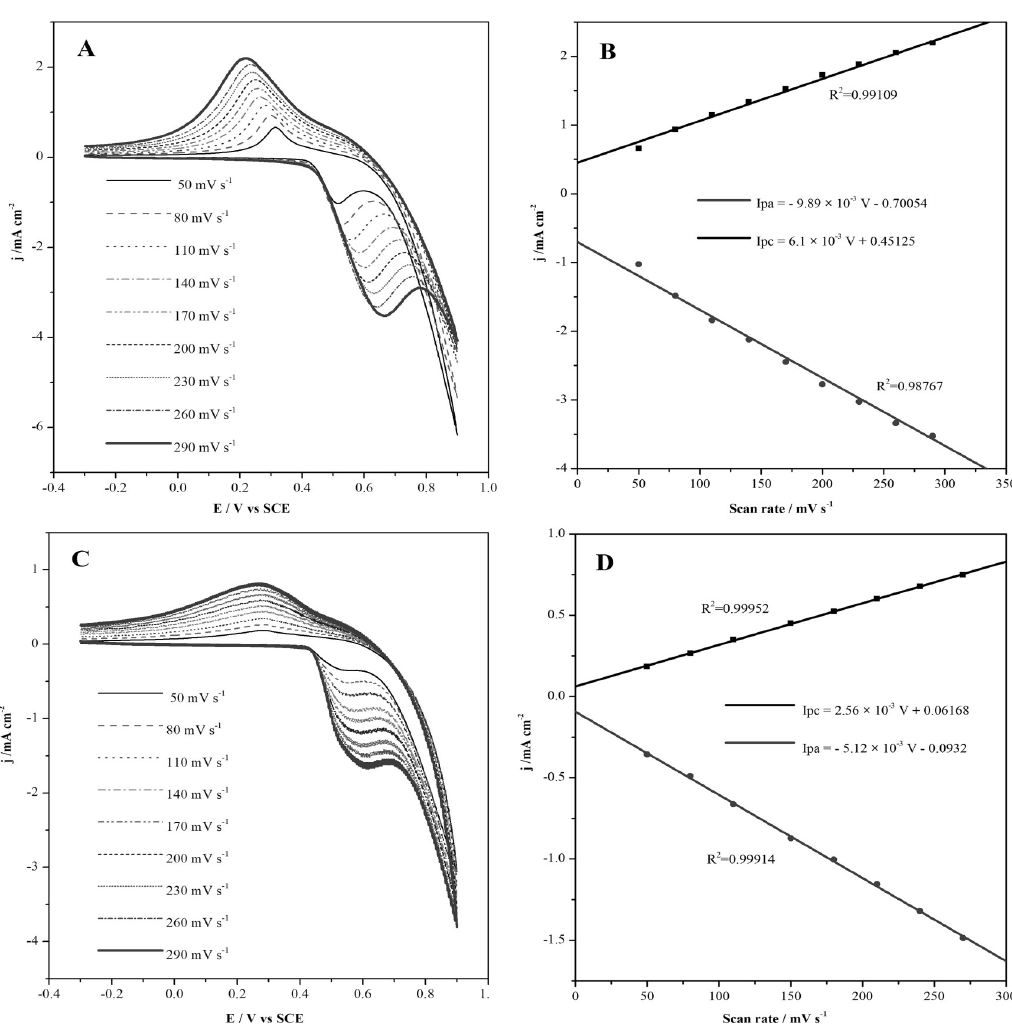
Fig 3. Electrochemical behavior of Cu@Ni CSNPs/Nafion/GCE and Cu@Ni CSNPs/N-GQDs/Nafion/GCE. CVs of Cu@Ni CSNPs/Nafion/GCE in 0.1 M NaOH at different scan rates ( A ) and plot of peak current versus the potential scan rates ( B ). CVs of Cu@Ni CSNPs/N-GQDs/Nafion/GCE in 0.1 M NaOH at different scan rates ( C ) and plot of peak current versus the potential scan rates ( D ). when the scan rate increasing, the current gradually increasing. The anodic potential range is from +0.5 ~ 0.7 V, which is the constant potential range for the next i-t curve test. Under the optimal conditions, +0.6 V is selected as the constant potential in the range of anodic potential of +0.5 ~ 0.7 V. In Fig 6A–6D they show the current-time responses at +0.6 V with an increasing glucose concentration every 50 s for the Cu@Ni CSNPs/Nafion/GCE and Cu@Ni CSNPs/N-GQDs/Nafion/GCE, and the linear relationship between the catalytic cur- rent and glucose concentration. As shown in Fig 6A, it is the i -t curve of Cu@Ni CSNPs/ Nafion/GCE at different glucose concentrations. The linear relationship between current and glucose concentration is shown in Fig 6B. The current response of the sensor exhibits a linear dependence on glucose concentration from 0.2 mM to 1 mM ( i = 0.0853 c—0.00018, R = 0.99973). The detection limit of glucose using Cu@Ni CSNPs/Nafion/GCE is found to be 111.4 μ M (S/N = 3) with the sensitivity of 85.3 μ A mM -1 cm -2 . As shown in Fig 6C, it is the i -t